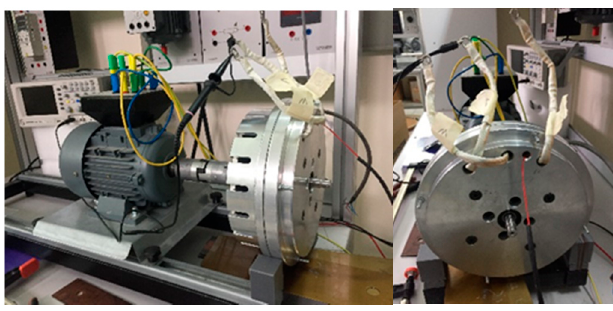
Figure 12. Magnetic flux densities on the surfaces.